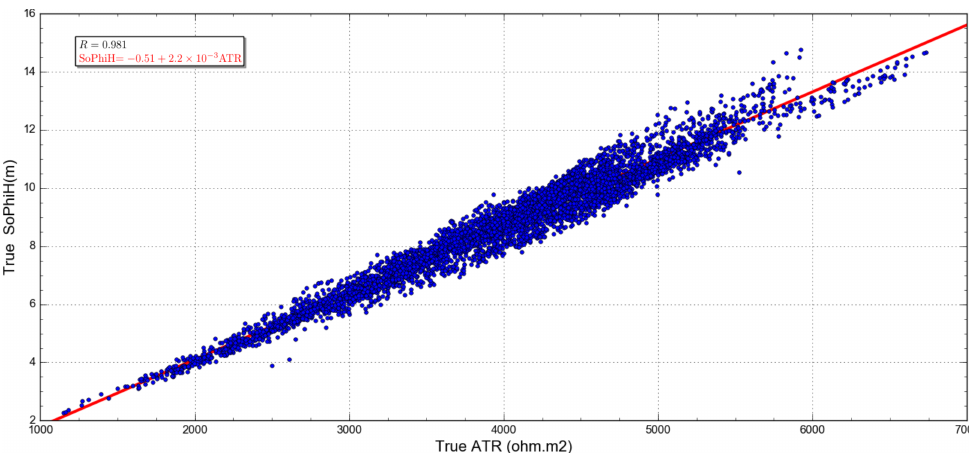
Figure 12. Relation between the true ATR (Figure 7) and the true SoPhiH (Figure 11) attributes calculated from the flow simulation. The red line shows the best least-square fit to the data (blue circles) with a correlation coefficient R of